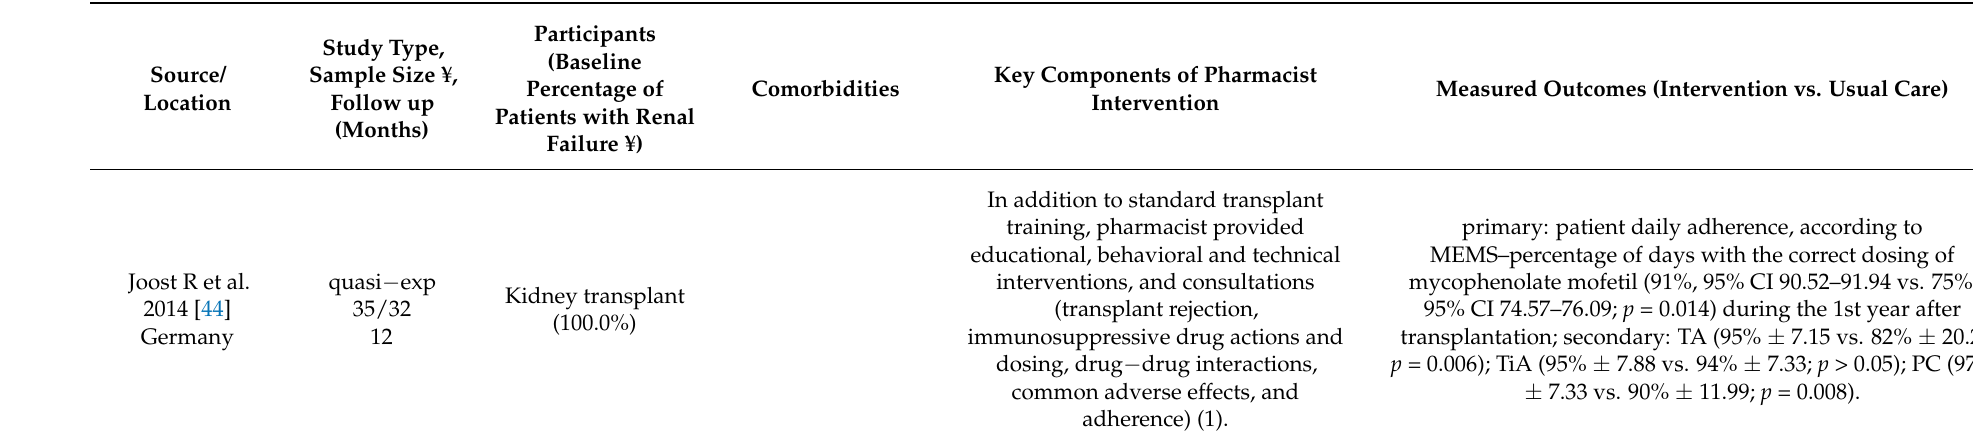
Measured Outcomes (Intervention vs. Usual